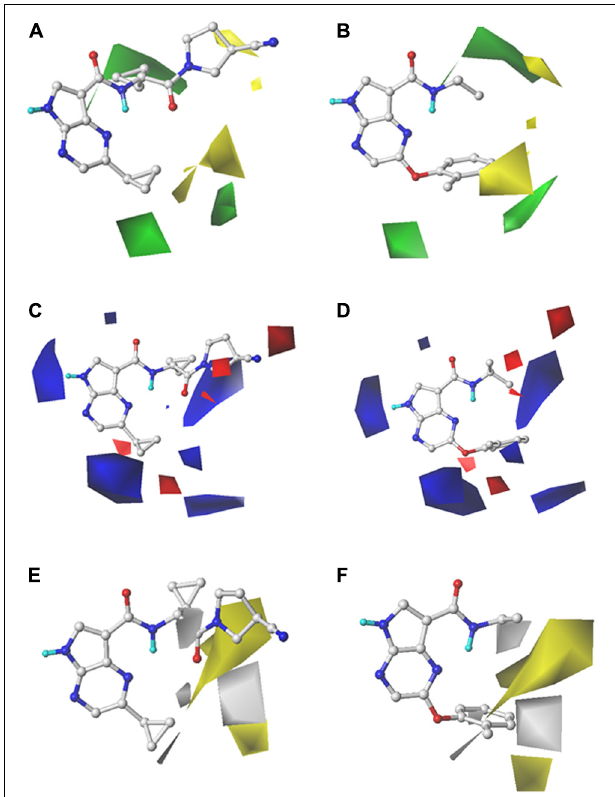
FIGURE 2 | StDev*Coeff contour maps of the best CoMFA and CoMSIA models with Cpd16 and Cpd24. (A,B) Steric contour map of CoMFA with Cpd16 and Cpd24; (C,D) Electrostatic contour map of CoMFA with Cpd16 and Cpd24; (E,F) Hydrophobic contour map of CoMSIA with Cpd16 and